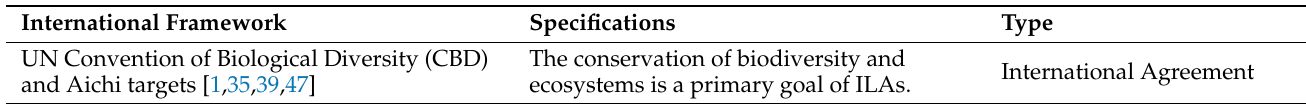
Table 3. Examples of international frameworks that promote Integrated Landscape